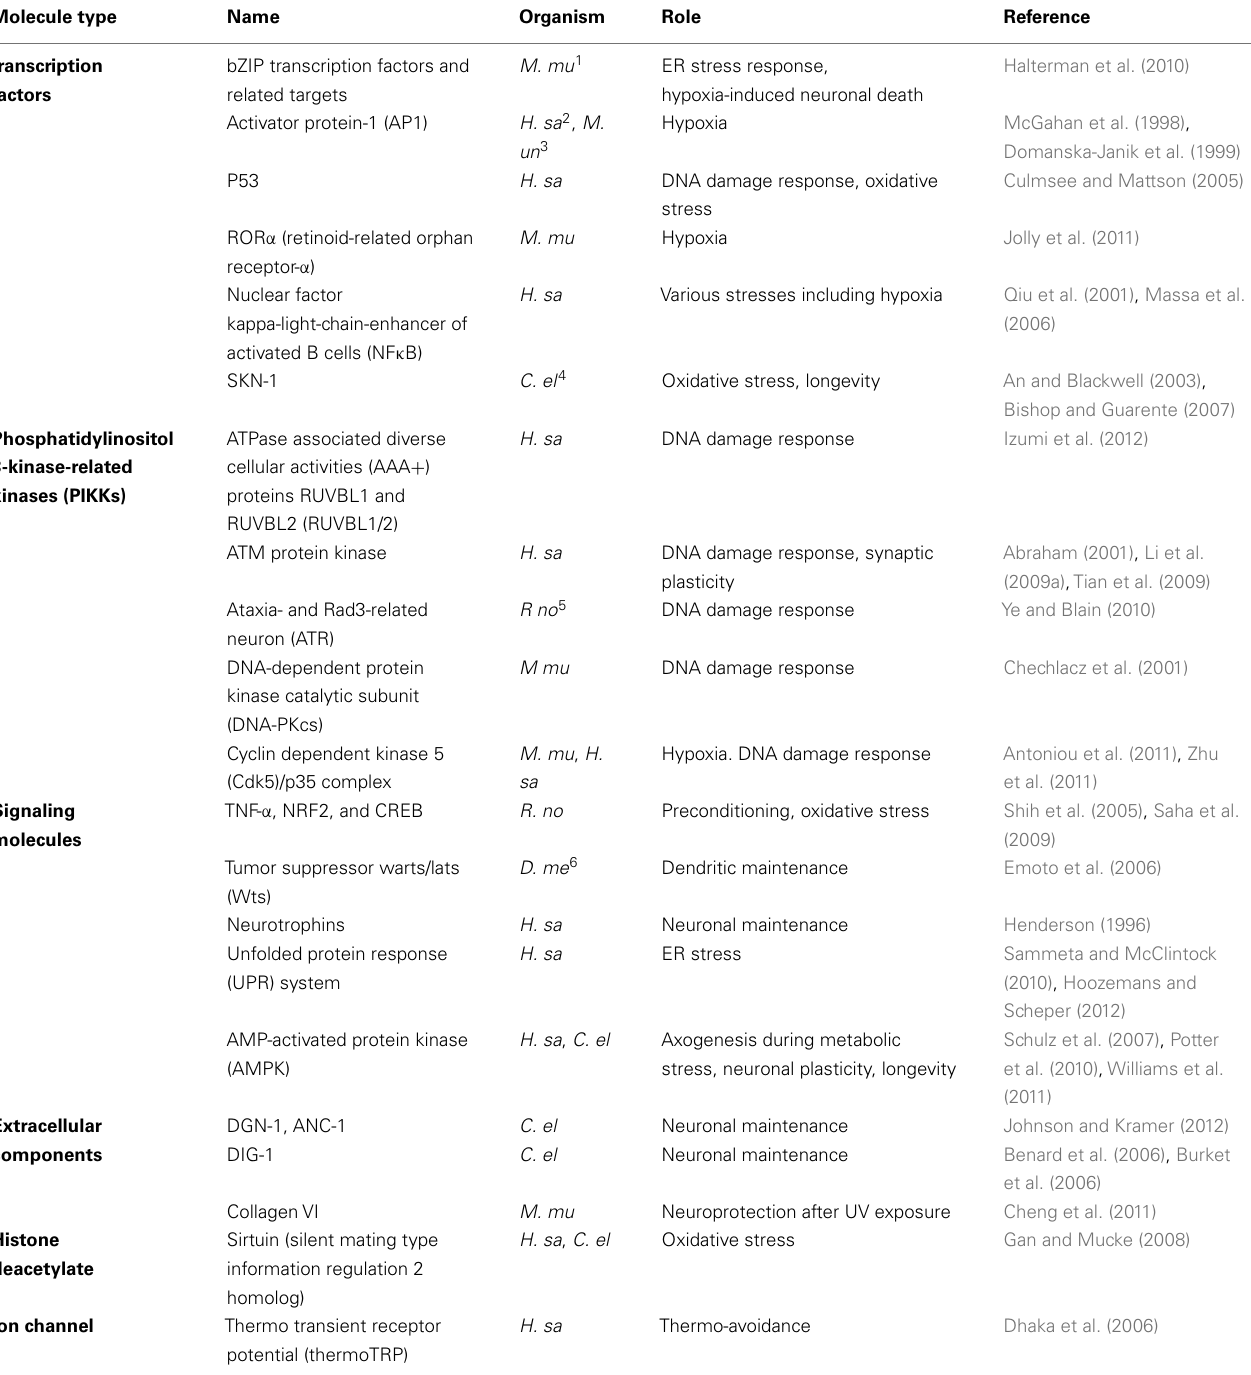
Table 1 | Molecules involved in neuronal responses to different stresses in various